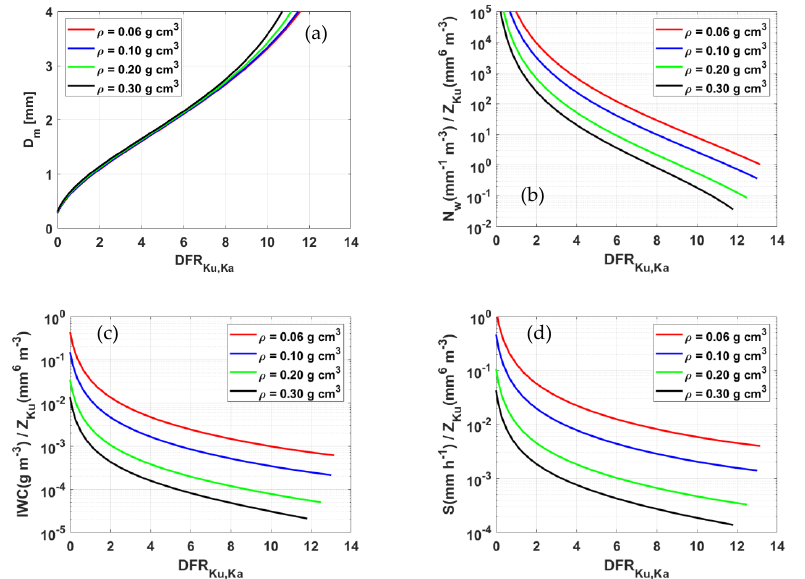
Figure 2. The dual-frequency ratios DFR versus D m ( a ), N w /Z Ku ( b ), IWC/Z Ku ( c ), and S/Z Ku ( d ) as a function of DFR when the densities of the aggregate are 0.06 g cm − 3 (red), 0.10 g cm − 3 (blue), 0.20 g cm − 3 (green), and 0.30 g cm − 3 (black); note that the elevation of radar is 0° and 𝜇 = 0.